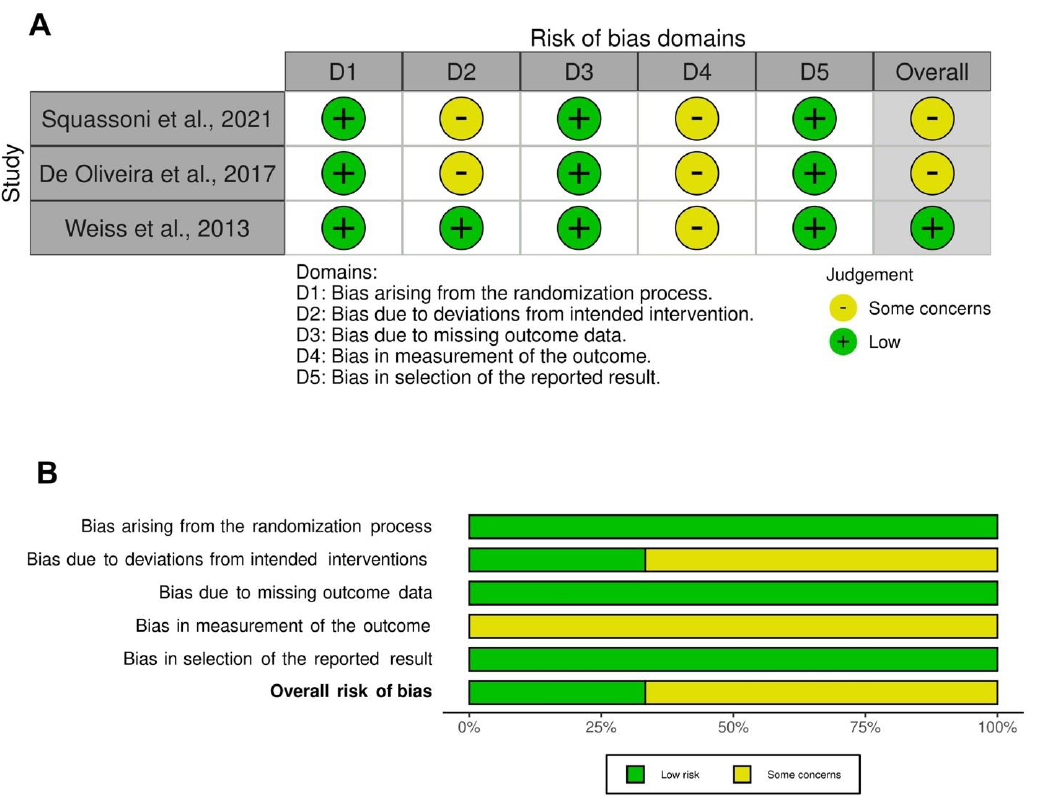
Figure 4. Assessment of the risk of bias via the traffic light plot of the RoB of each included RCT via the Cochrane RoB2 Tool ( A ) and the weighted plot for the assessment of the overall risk of bias via the Cochrane RoB 2 tool ( B ) ( n = 3 studies). Traffic light plot reports five risk of bias domains: D1, bias arising from the randomization process; D2, bias due to deviations from intended intervention; D3, bias due to missing outcome data; D4, bias in measurement of the outcome; D5, bias in selection of the reported result; yellow circle indicates some concerns on the risk of bias and green circle represents low risk of bias. RCT: randomized controlled trial; RoB: risk of bias [56 – 58]. In agreement with the recommendation [40] for testing funnel plot asymmetry, only the meta-analysis for the impact of stem cell-based therapies and derived products on FEV 1 vs. baseline or CTL was eligible for publication bias detection. The visual inspection of funnel plot reported asymmetry and dispersion (Figure 5A), although the Egger’s test indicated that the results were not affected by significant ( p = 0.670) publication bias (Fig- ure 5B). The sensitivity analysis performed to resolve heterogeneity by excluding the study of Harrell et al. [46] reduced the visual asymmetry and dispersion and confirmed the lack of significant ( p = 0.669) publication bias (Figure 5C,D).